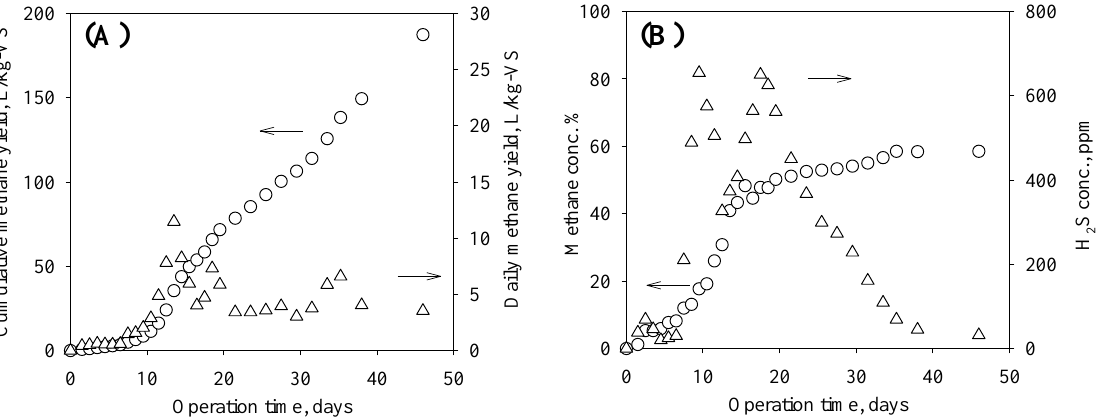
Figure 2. Daily and cumulative methane yields ( A ) and methane and hydrogen sulfide concentrations in biogas ( B ). Note: arrows point to the corresponding y axis for circles and triangles.